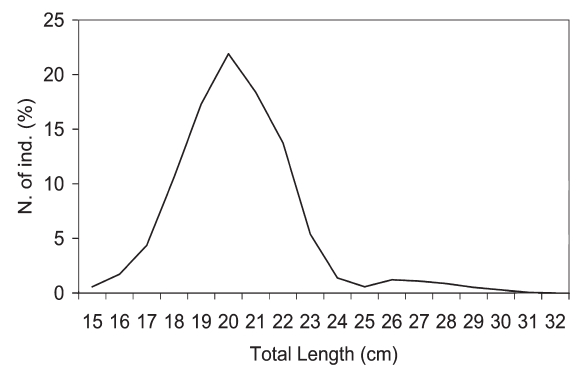
Fig. 6. – Size-frequency distribution of the soles caught with the rapido trawl with a 36.8 mm mesh